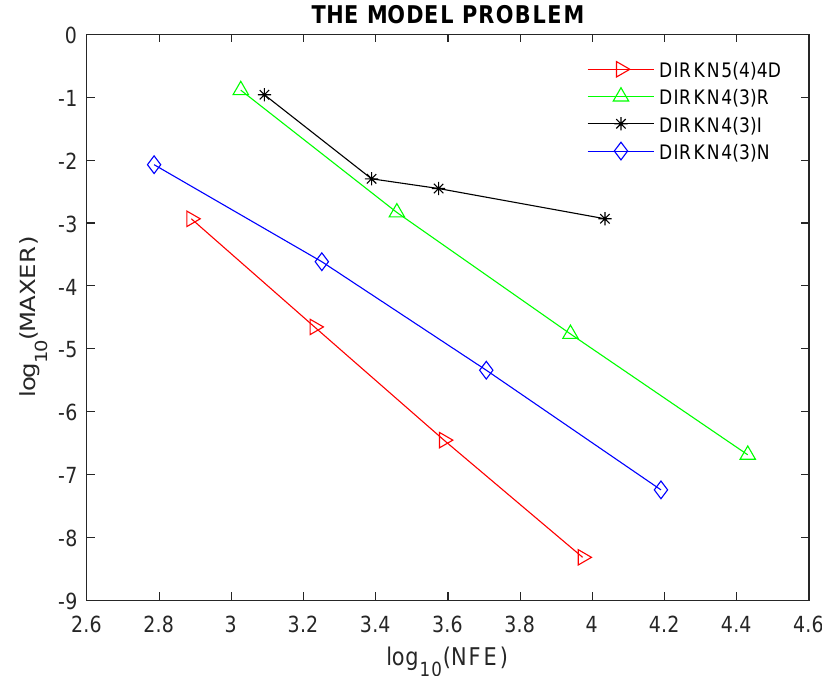
Figure 1. Efficiency curves for Example